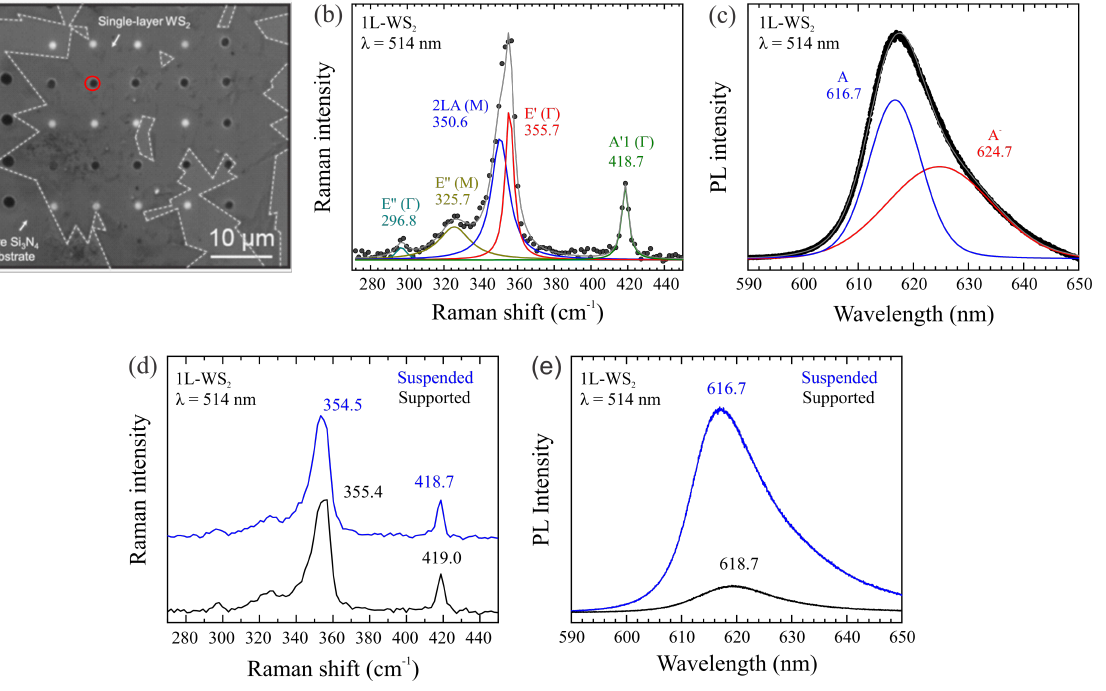
Figure 1. ( a ) WS 2 sample transferred over the drilled Si 3 N 4 substrate. ( b ) Raman spectrum for 1L- WS 2 as synthesized on SiO 2 /Si substrate excited with 514 nm laser line. ( c ) PL spectrum of 1L-WS 2 as synthesized on SiO 2 /Si substrate. ( d ) Comparison of Raman spectra of supported (blue trace) and suspended (black trace) regions of 1L-WS 2 transferred. The huge discrepancy in PL intensity for supported and suspended 1L-WS 2 regions is shown in ( e ). The red circle was the region were the measurements were